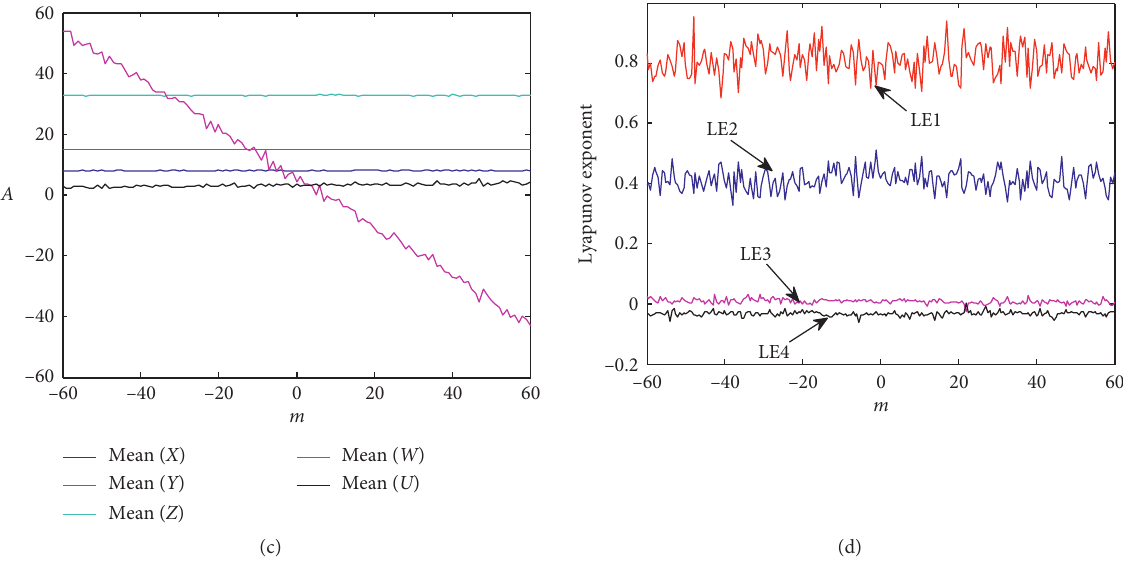
Figure 11: The offset boosting with m �− 55 (green), m � 0 (blue), and m � 55 (magenta): (a) phase portrait in the X - W plane; (b) phase portrait in the Y - W plane; (c) the average values of the variables X Y , Z , W , and U ; (d) LEs